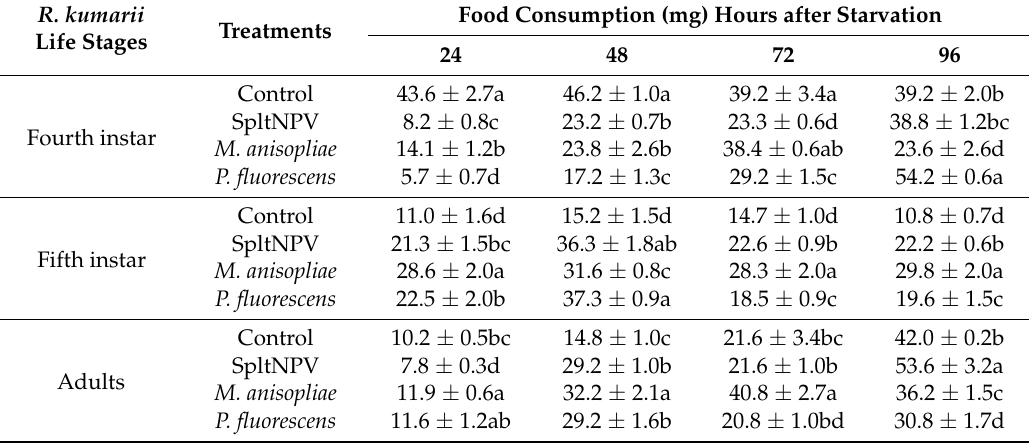
Table 3. Effect of entomopathogenic microbe-treated and untreated Spodoptera litura prey on the food consumption (mg) of Rynocoris kumarii different life stages at 24, 48, 72, and 96 h after